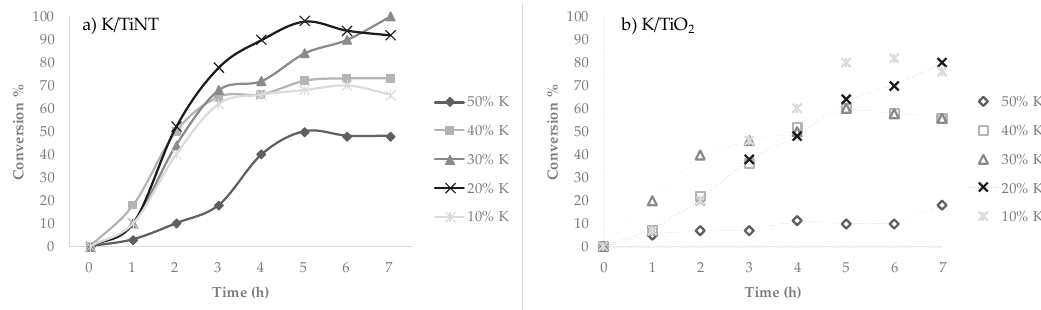
Figure 12. Conversion of canola oil to methyl esters with ( a ) K/TiNT and ( b ) K/TiO2